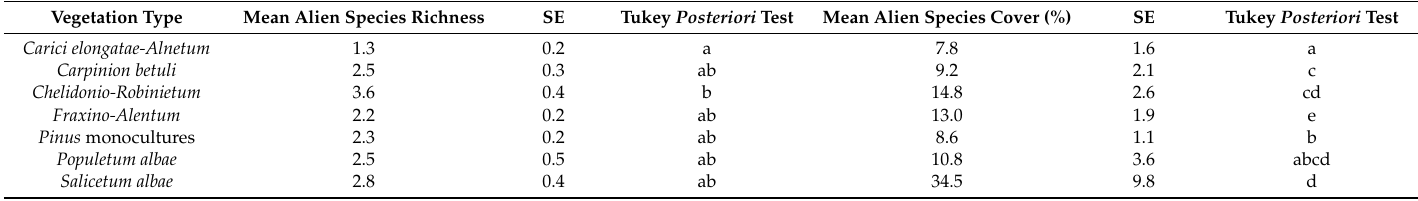
Table 4. Mean alien species richness and cover in the vegetation types of urban forests assessed using Poisson GLM for richness and zero-inflated Beta GLM for cover (see Tables S5 and S6 for full models, respectively) and Tukey posteriori test. Vegetation types marked by the same letter did not differ statistically significantly at p =